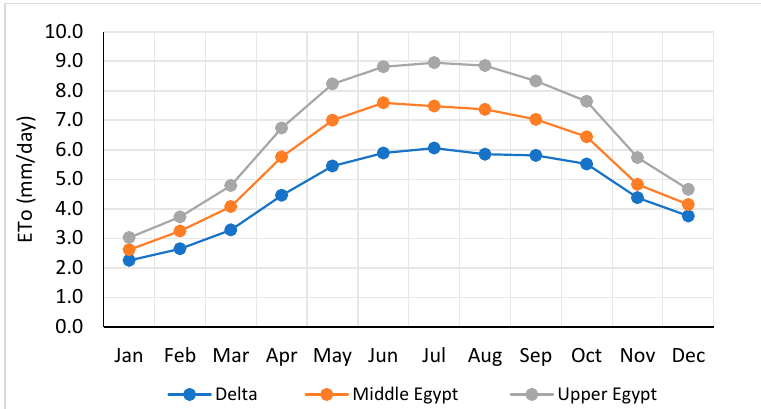
Figure 3. Reference evapotranspiration for the agro-ecological zones as the mean of a five-year period from 2015 to 2019.